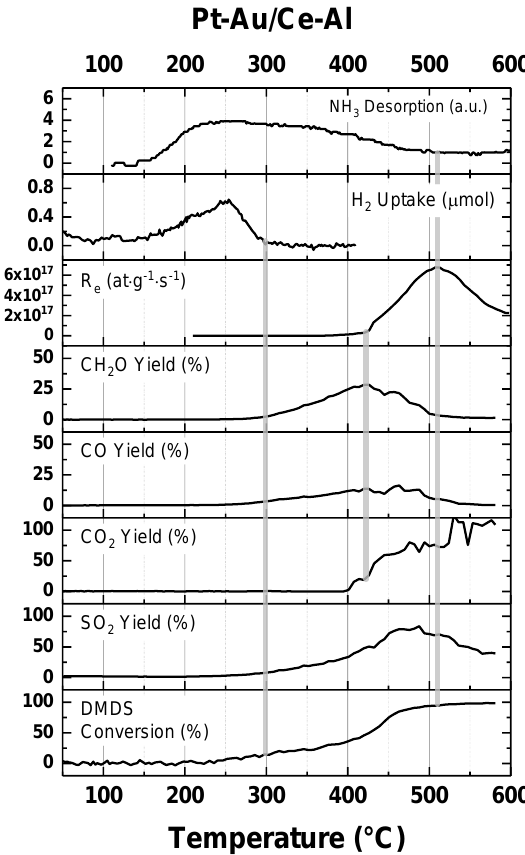
Figure 15. Summary of DMDS conversion, product yields, oxygen exchange rate, H 2 uptake, and NH 3 desorption results for the Pt–Au / Ce–Al catalyst. The temperature scale in the result is common for the different tests, and y axis values are related to each experiment.